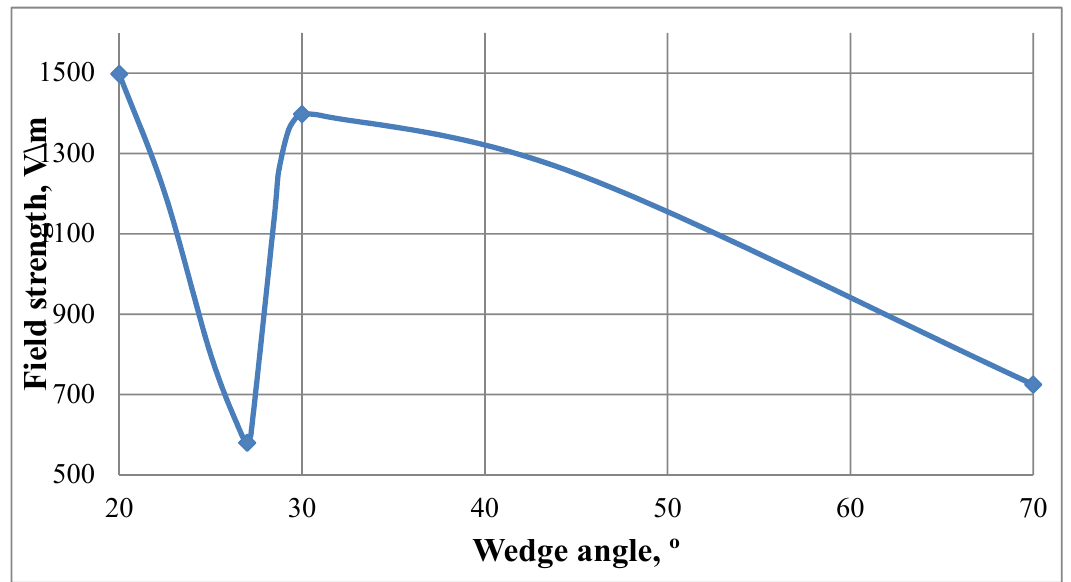
Figure 3. The dependence of the electric field on the angle of the wedge-shaped profile.